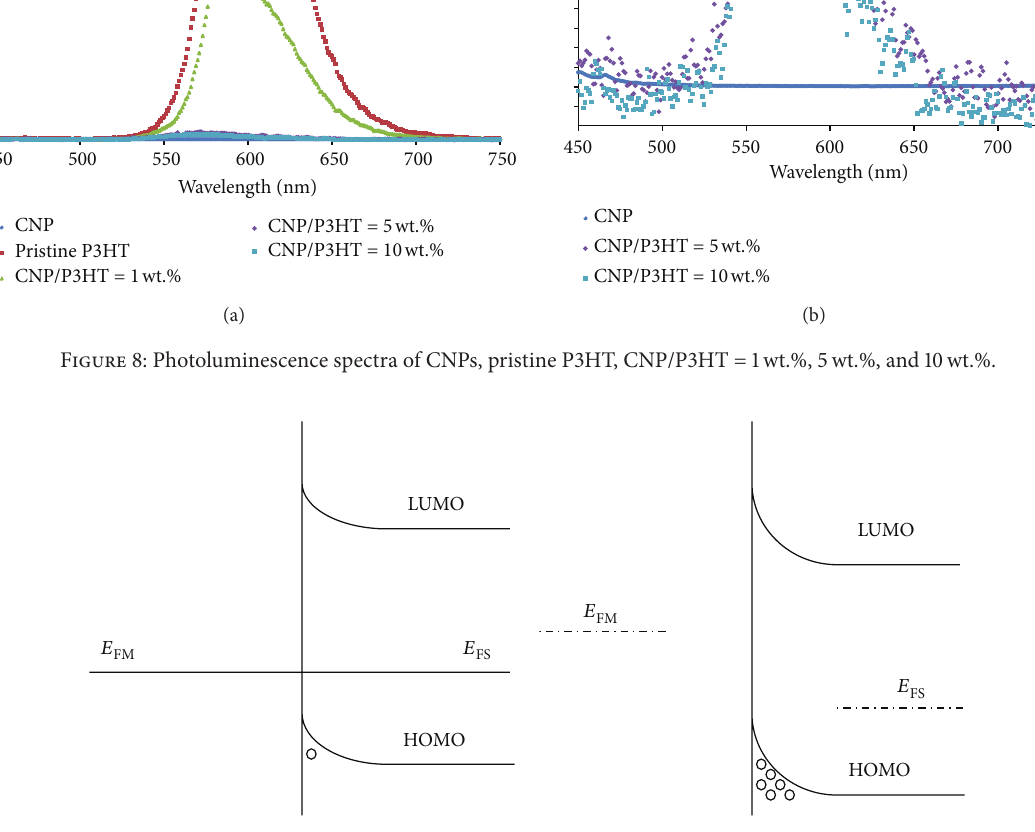
Figure 9: Energy band diagrams for (a) equilibrium condition with 𝑉